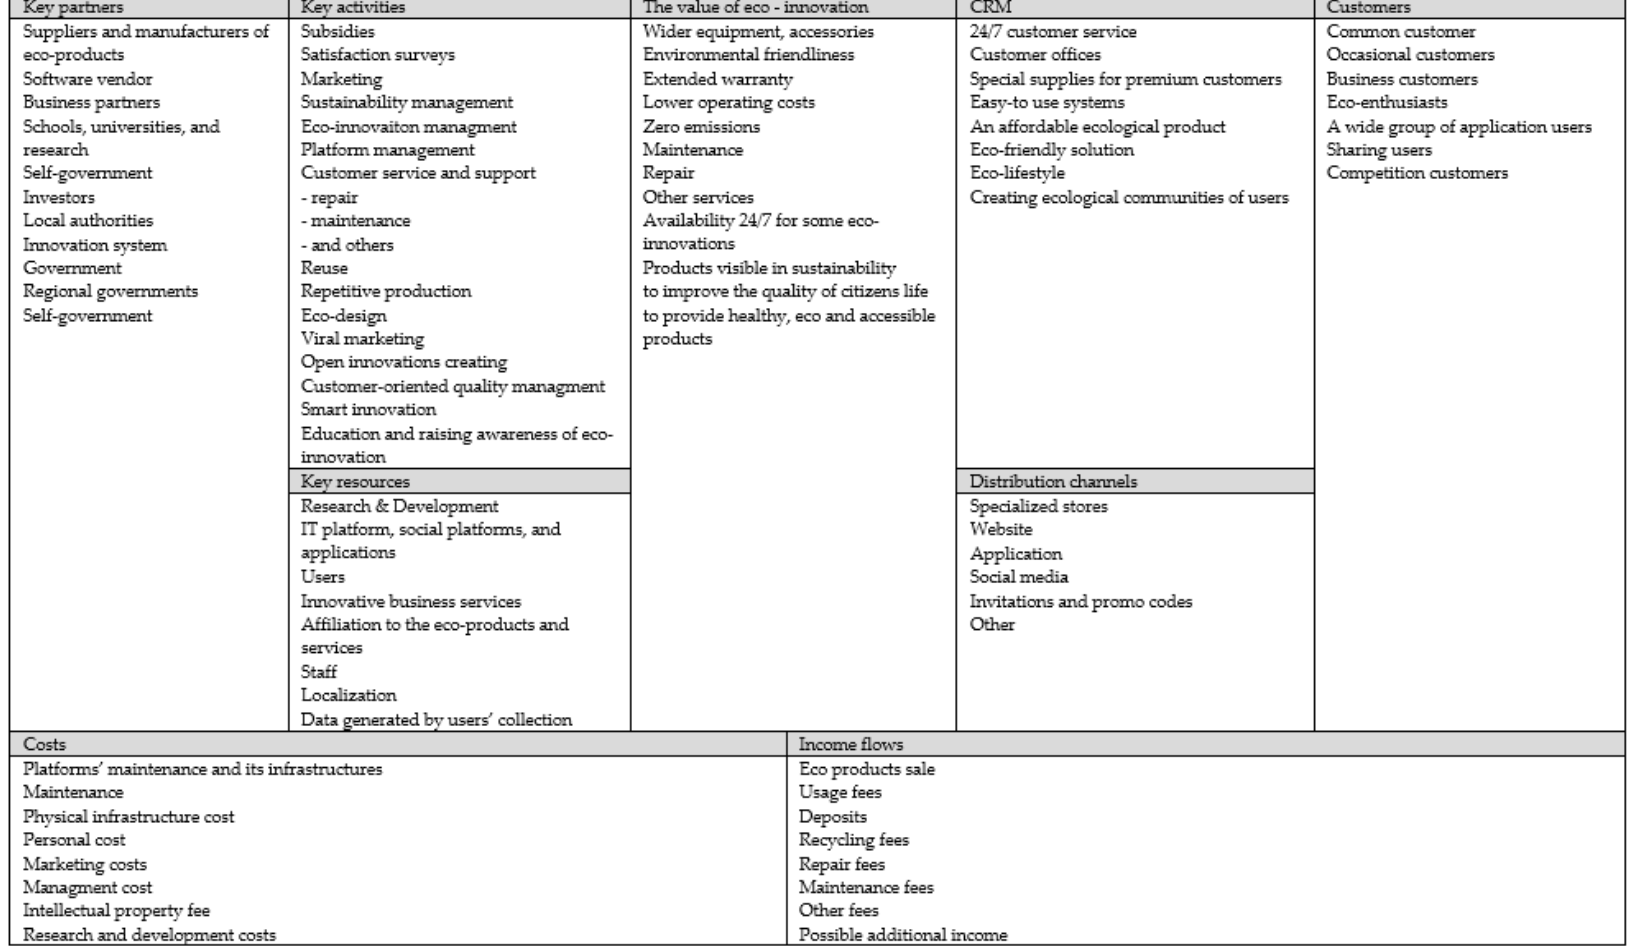
Figure 1. Proposal of an open business model of eco-innovation as an opportunity to strengthen the development of sustainability in Slovakia.